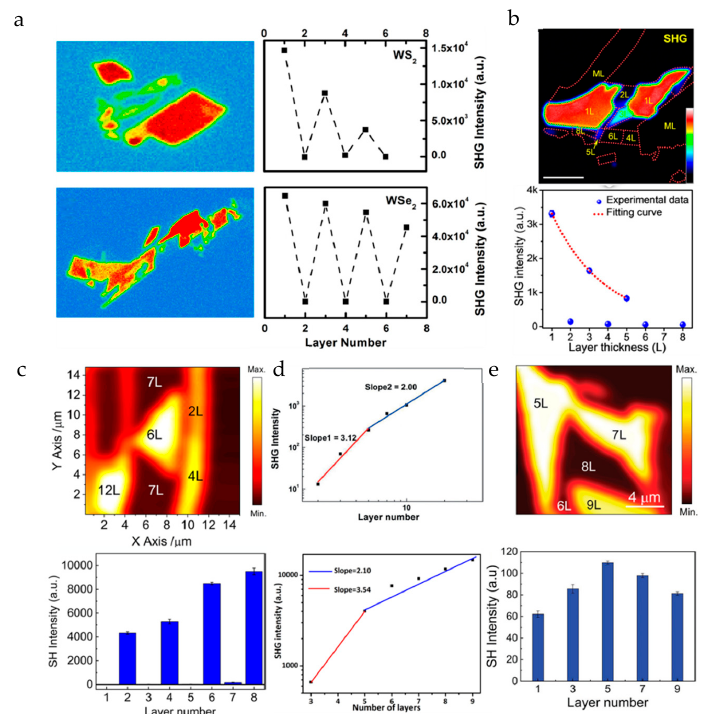
Figure 4. SHG scanning image of 2D materials and the relationship between the SHG signal intensity and the number of material layers: ( a ) WS 2 and WSe 2 . Reproduced from [39], with permission from Springer Nature, 2013. ( b ) MoS 2 . Reproduced from [17], with permission from American Chemical Society, 2016. ( c ) ReS 2 . Reproduced from [41], with permission from American Chemical Society, 2018. ( d ) GaSe and InSe. Reproduced from [42,43]. with permission from John Wiley and Sons, 2014 and American Chemical Society, 2019 ( e ) MoTe 2 . Reproduced from [44]. with permission from John Wiley and Sons,